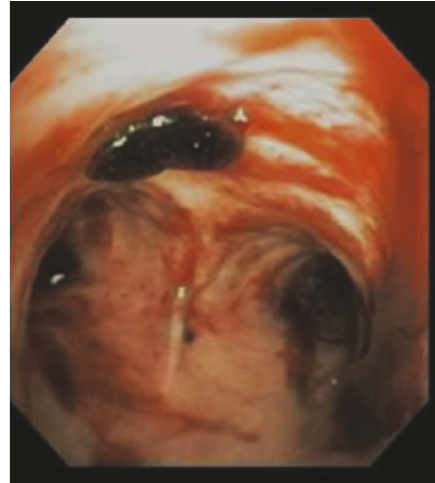
Figure 2: Bronchoscopy showing blood in the airways left more than right (case 2).